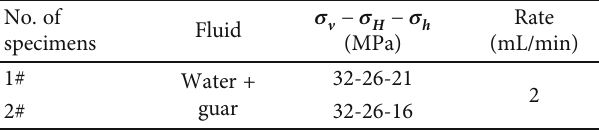
Table 2: Experimental parameters for water-based fracturing. No. of